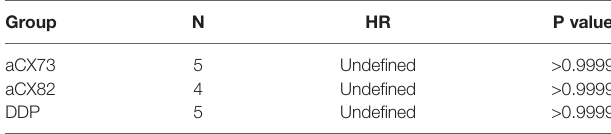
N, the number of mice; HR, hazard